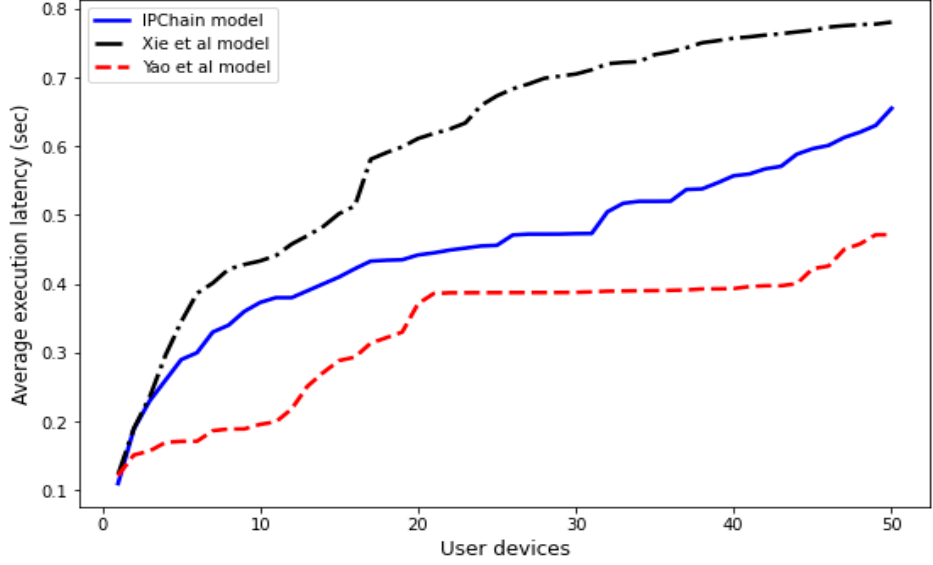
Figure 8. Evaluation of execution latencies of the models.